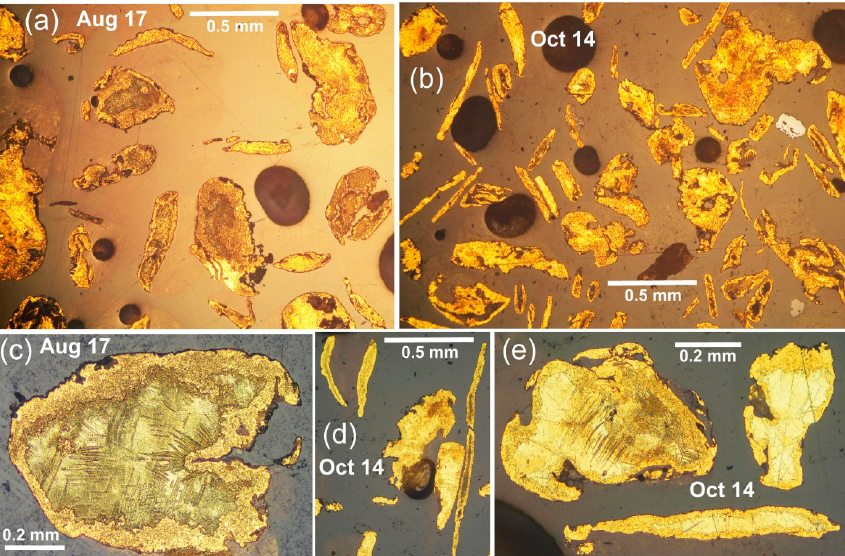
Figure 4. Incident light view of a polished section, showing the typical appearance of gold particles from the Waikaia placer mine. Sections have been etched with aqua regia to show core and rim textures. ( a ) General view of sample taken in August 2017 (upstream); compared to ( b ) sample taken in October 2014 (downstream); ( c ) Close view of internal texture of a particle from August 2017 sample; ( d , e ) Close views of particles from October 2014 sample.